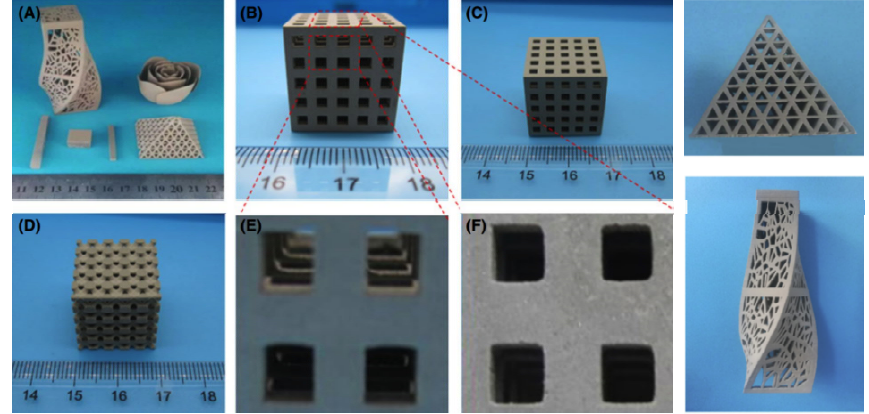
Fig. 30 SiC green bodies by DLP. Reproduced with permission from Ref. [86], © Elsevier Ltd and Techna Group S.r.l. 2019.